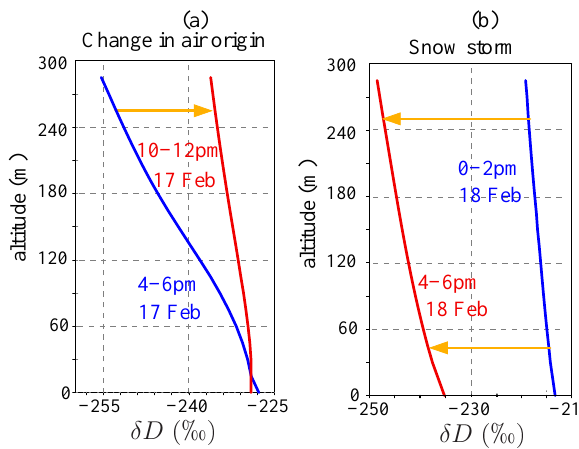
Fig. 8. Profiles of δ D for some events that demonstrate where a mixing line analysis fails: (a) a change in air mass origin associated with a change in the wind direction and, (b) decreases in the mean δ D values of the entire profile associated with the passage of an air mass that has undergone precipitation. The red curve occurs several hours after the blue profile, as indicated by the